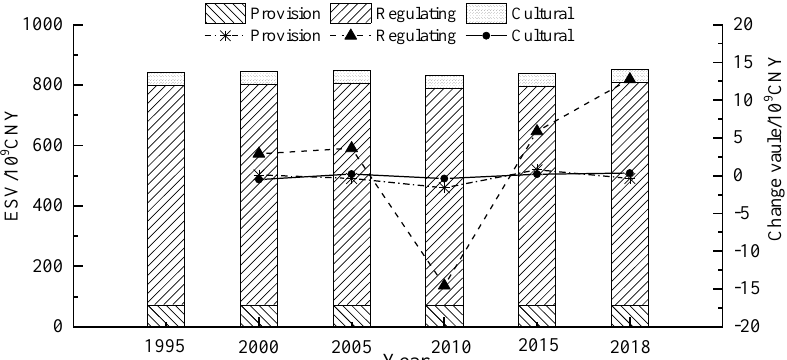
Figure 4. The value of each ecosystem service and change in respective years (1995 to 2018) in the Yellow River Basin, China.